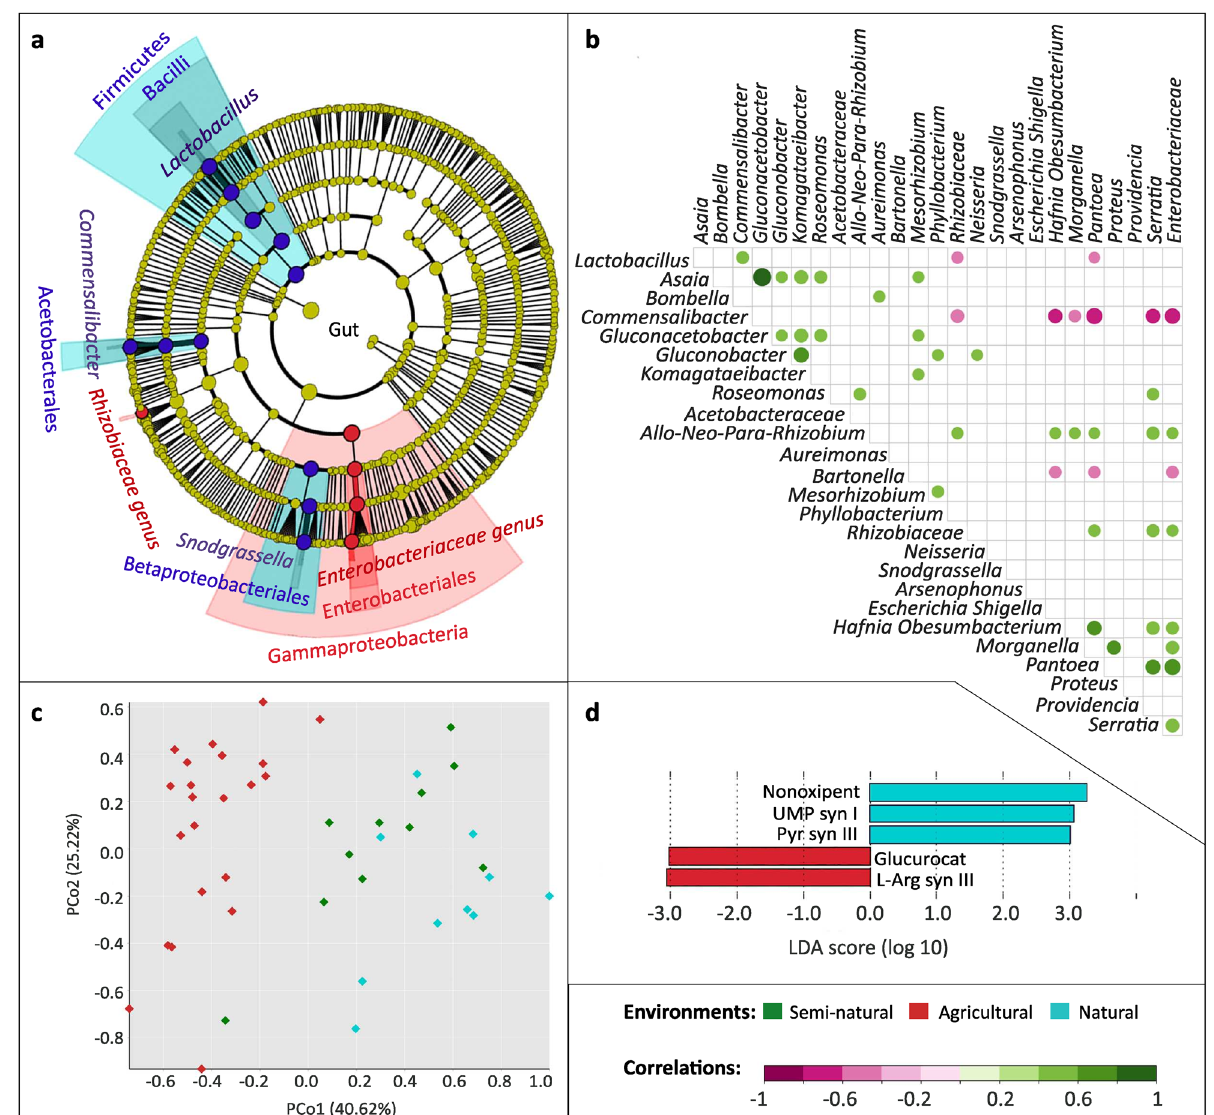
Figure 4. Characterization of bacterial communities of worker gut samples. ( a ) Cladogram of significantly enriched bacteria in each environment, from phylum to genus level, according to LEfSe. LEfSe cladogram results are plotted according to phylogeny. The outermost circle corresponds to the lowest taxonomic rank (genera, level to which ASVs were collapsed). From there, each circle equals a higher taxonomic rank, with phyla being the inner circle. Only significant taxa are plotted. ( b ) Spearman correlation analysis of the honey bee gut bacterial communities at p < 0.05. ( c ) Principal Coordinate Analysis (PCoA) of samples according to the predictive functional profile. ( d ) Significantly expressed MetaCyc pathways (predicted functional profile) according to LEfSe. The bigger the LDA value obtained for a feature, the more significant. Only significant features are plotted in the histogram. ( d ) Nonoxipent: Pentose phosphate pathway I (non-oxidative branch), UMP syn I: UMP biosynthesis I, Pyr syn III: Pyrimidine deoxyribonucleotides de novo biosynthesis III, Glucurocat: β-d-glucuronosides degradation, L-Arg syn III: l-arginine biosynthesis III (via N-acetyl-l- citrulline). Plotting: Cladograms and histograms of LEfSe results were plotted in Galaxy (web application, https:// hutte nhower. sph. harva rd. edu/ galaxy/) and taxa names cleaned with INKSCAPE (v0.92.3-1, https:// inksc ape. org/). PCoAs were plotted using Vega editor (v5.22.1, https:// vega. github. io/ edito